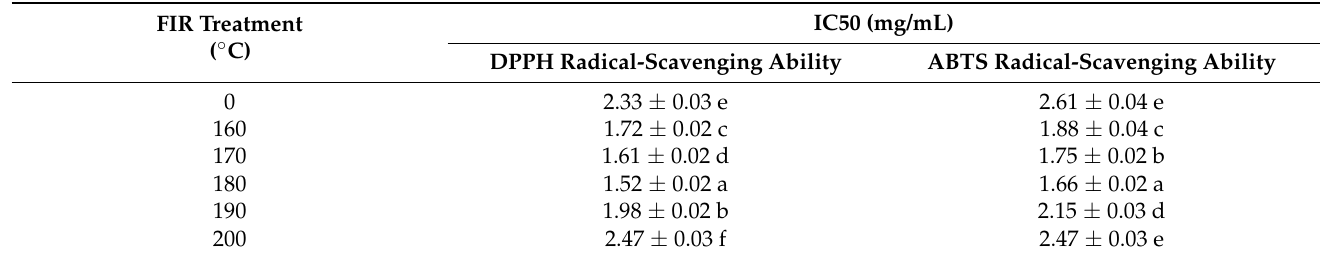
Table 1. Changes in antioxidant activities (DPPH/ABTS radical-scavenging ability) in ginseng leaves treated by FIR at different